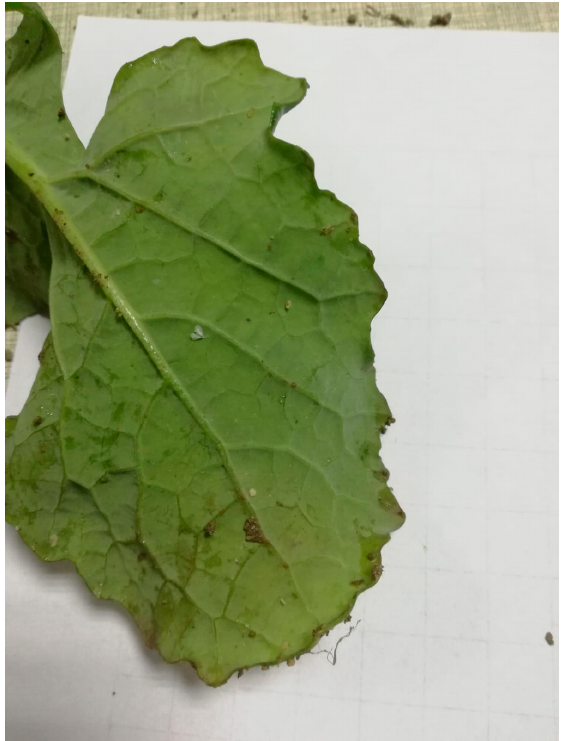
Figure 1. B. brassicae infestation on the leaf of the Brassicaceae hybrid.